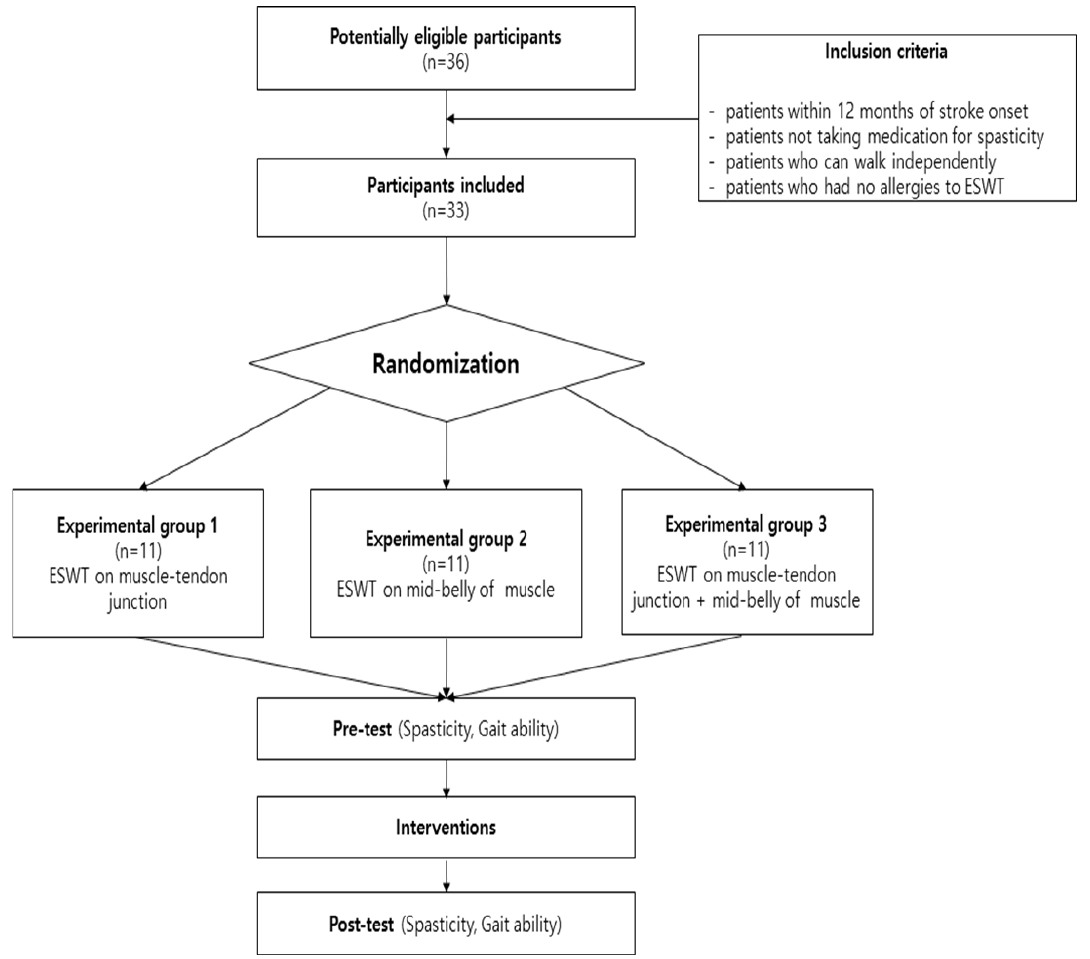
Figure 1. Flowchart of research.